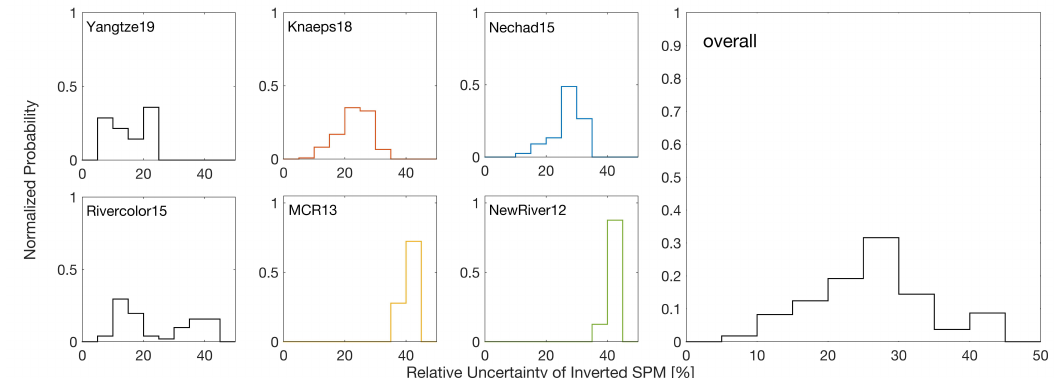
Figure 4. Normalized frequency of uncertainty of Suspended Particulate Matter–SPM modeled data ( ± σ SPM ) derived from MW algorithm for individual datasets and